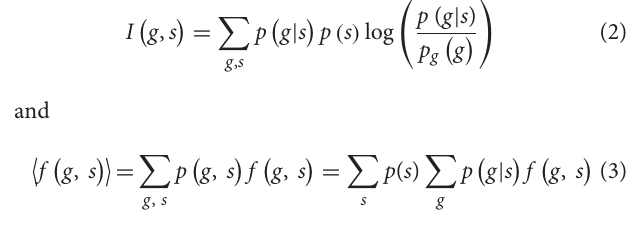
. The colored area in Figure 3E corresponds to the support of